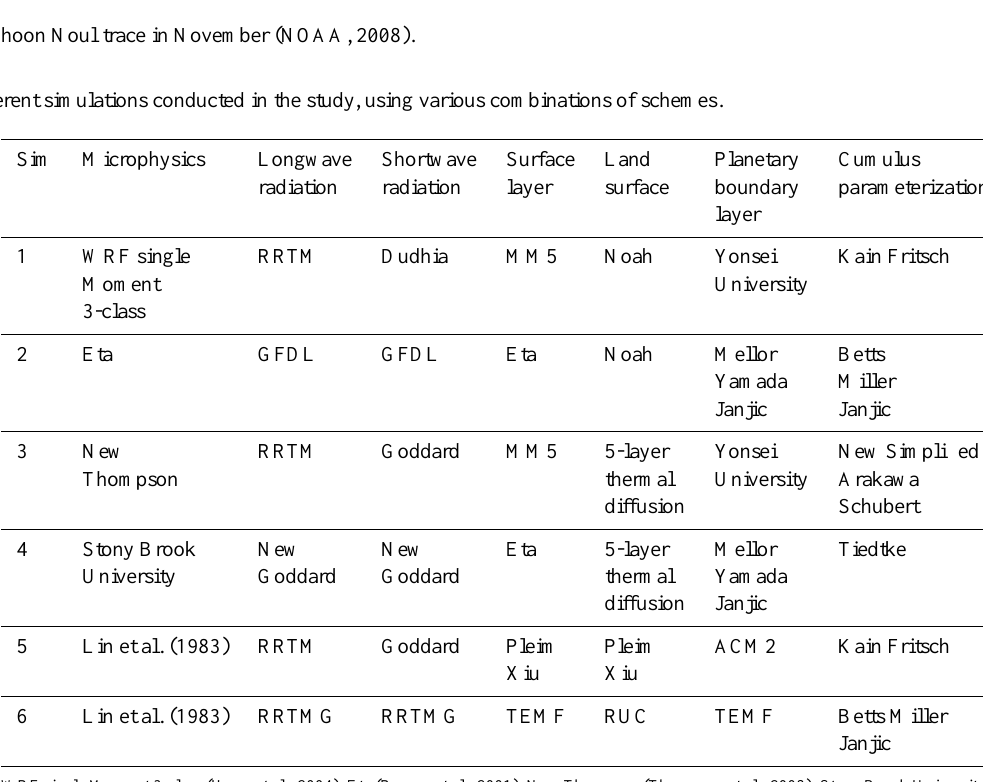
Figure 2 indicates the defined domains for modelling.